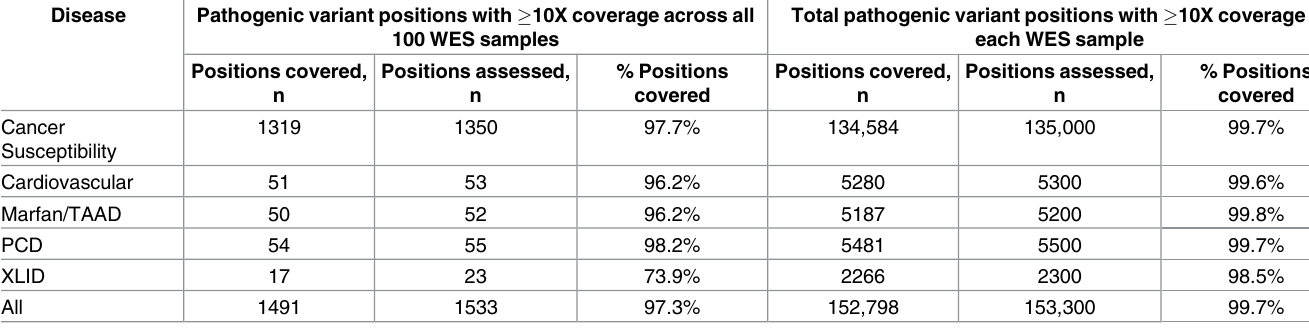
Table 1. Exome sequencing coverageby disease type. Disease Pathogenic variant positions with (cid:21) 10X coverage across all 100 WES